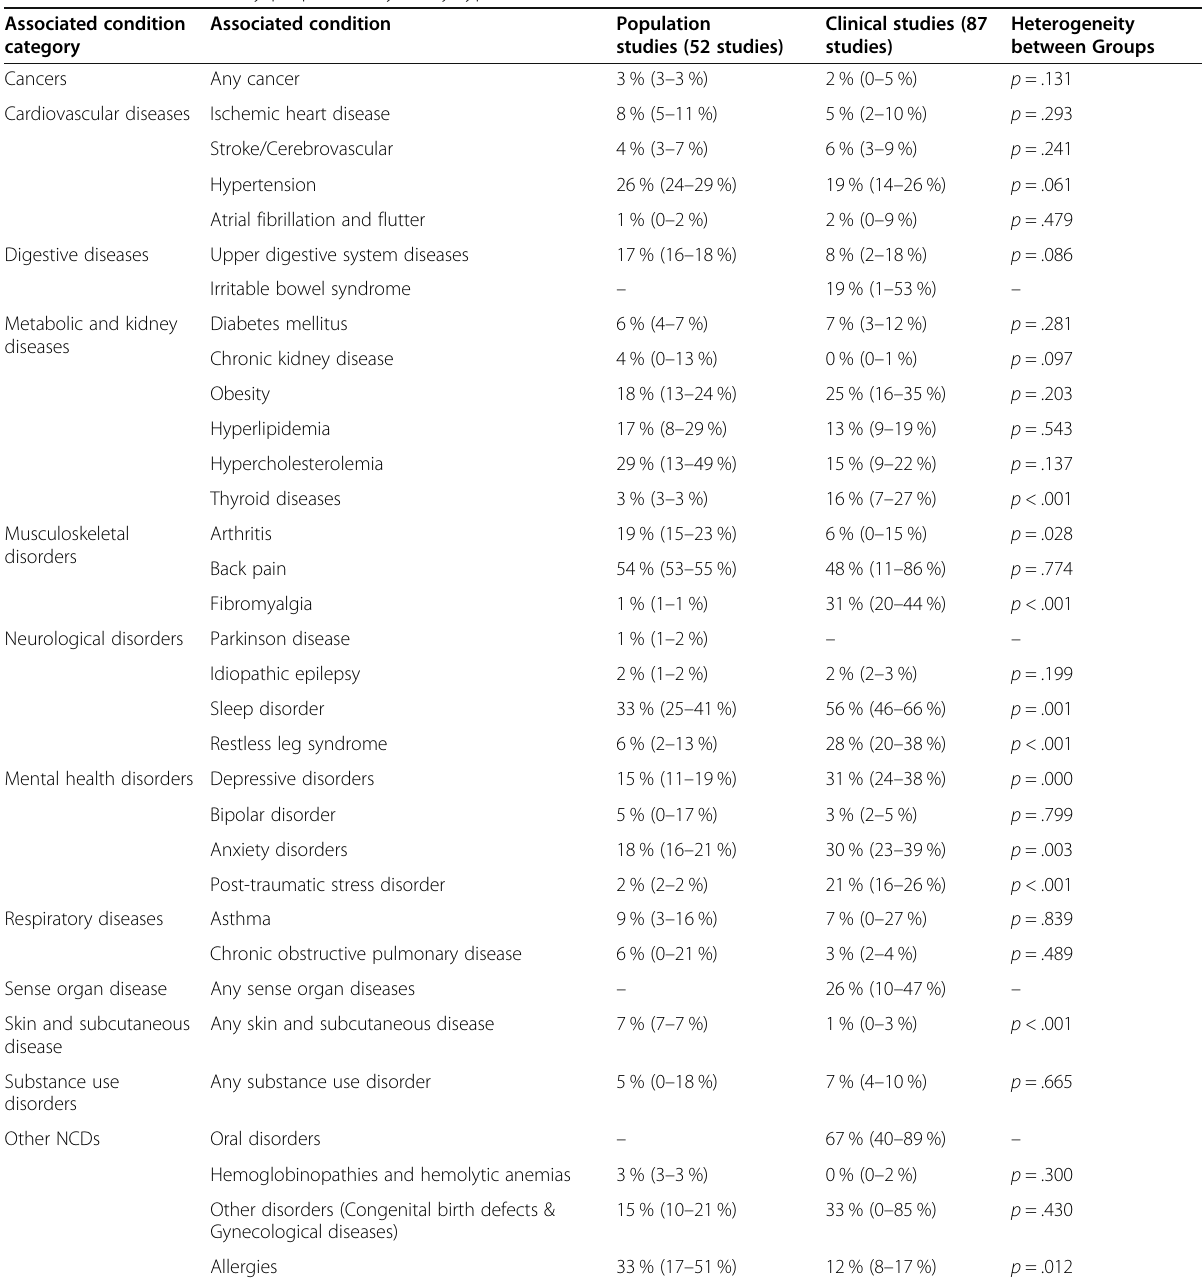
Table 3 Pooled comorbidity proportion by study